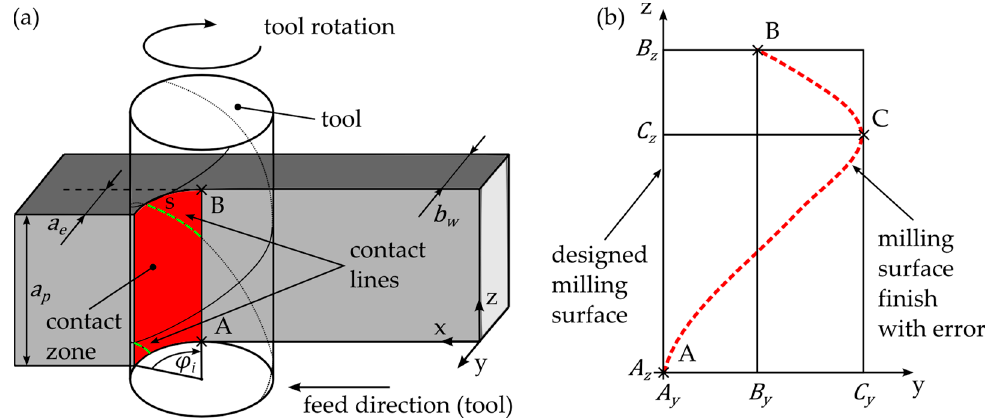
Figure 2. ( a ) Milling geometry with coordinate system in 3-D view; ( b ) View along x-axis with a typical profile line of the dimensional deviation.